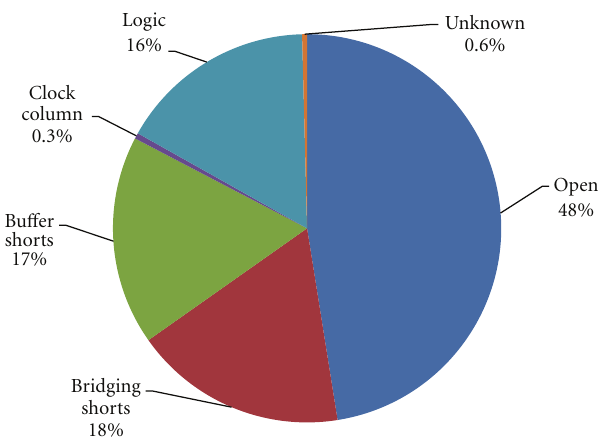
Figure 3: The distribution of sensitive configuration bits among utilized resources.